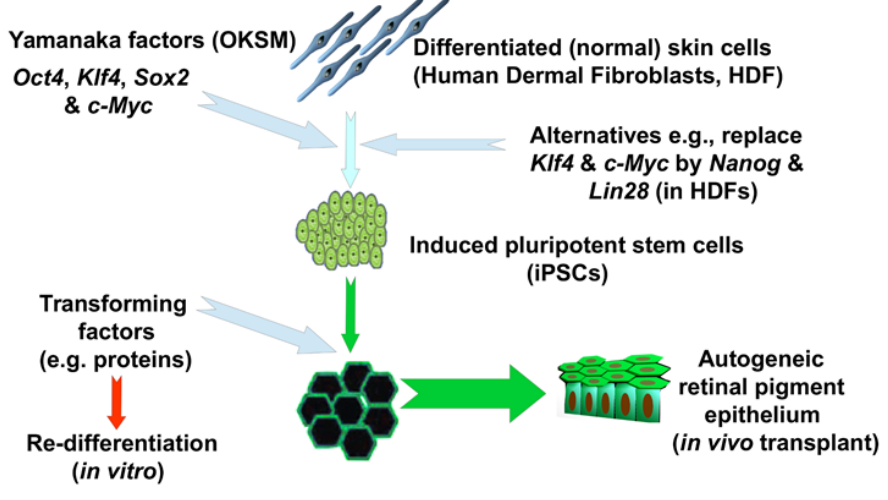
Figure 1. Outline of the procedure underlying the production of iPSC. The example given is of their use in treating age-related macular degeneration [11].